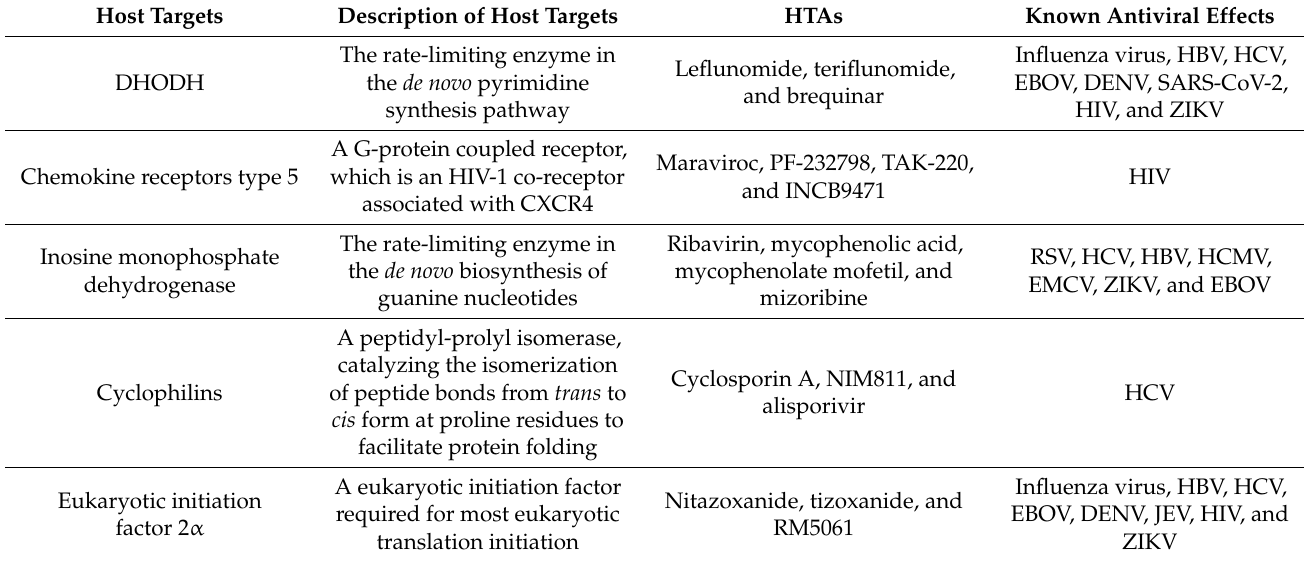
Table 1. Host targets and antiviral activities of host-targeting antivirals